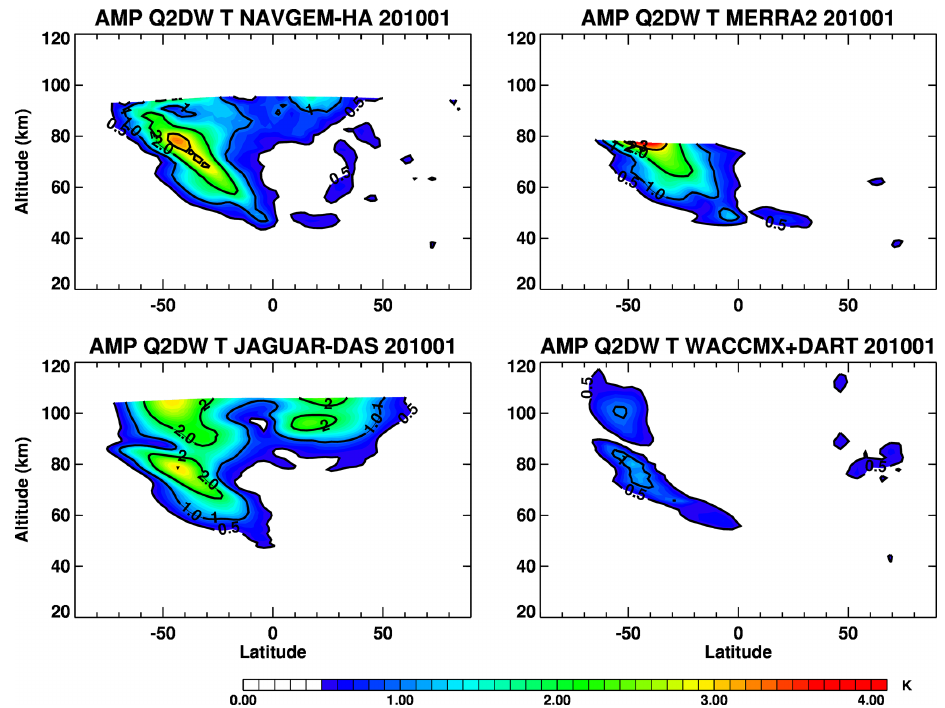
Figure 14. Monthly mean amplitude of the westward zonal wave number 3 quasi-2d (Q2DW) wave in temperature for January 2010 from NAVGEM-HA, MERRA2, JAGUAR-DAS, and WACCMX + DART.